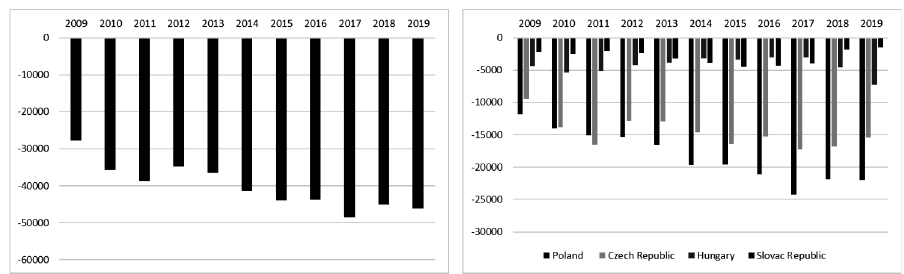
Figure 9. Total deficit of trade balance Figure 10. Deficit in trade balance of V4 of V4 with China (USD, million) with China (USD,